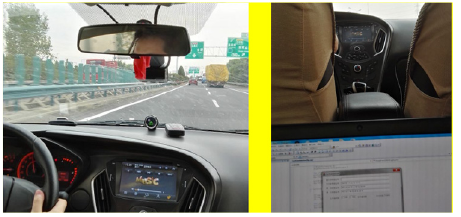
Figure 2 Naturalistic driving experiment data acquisition